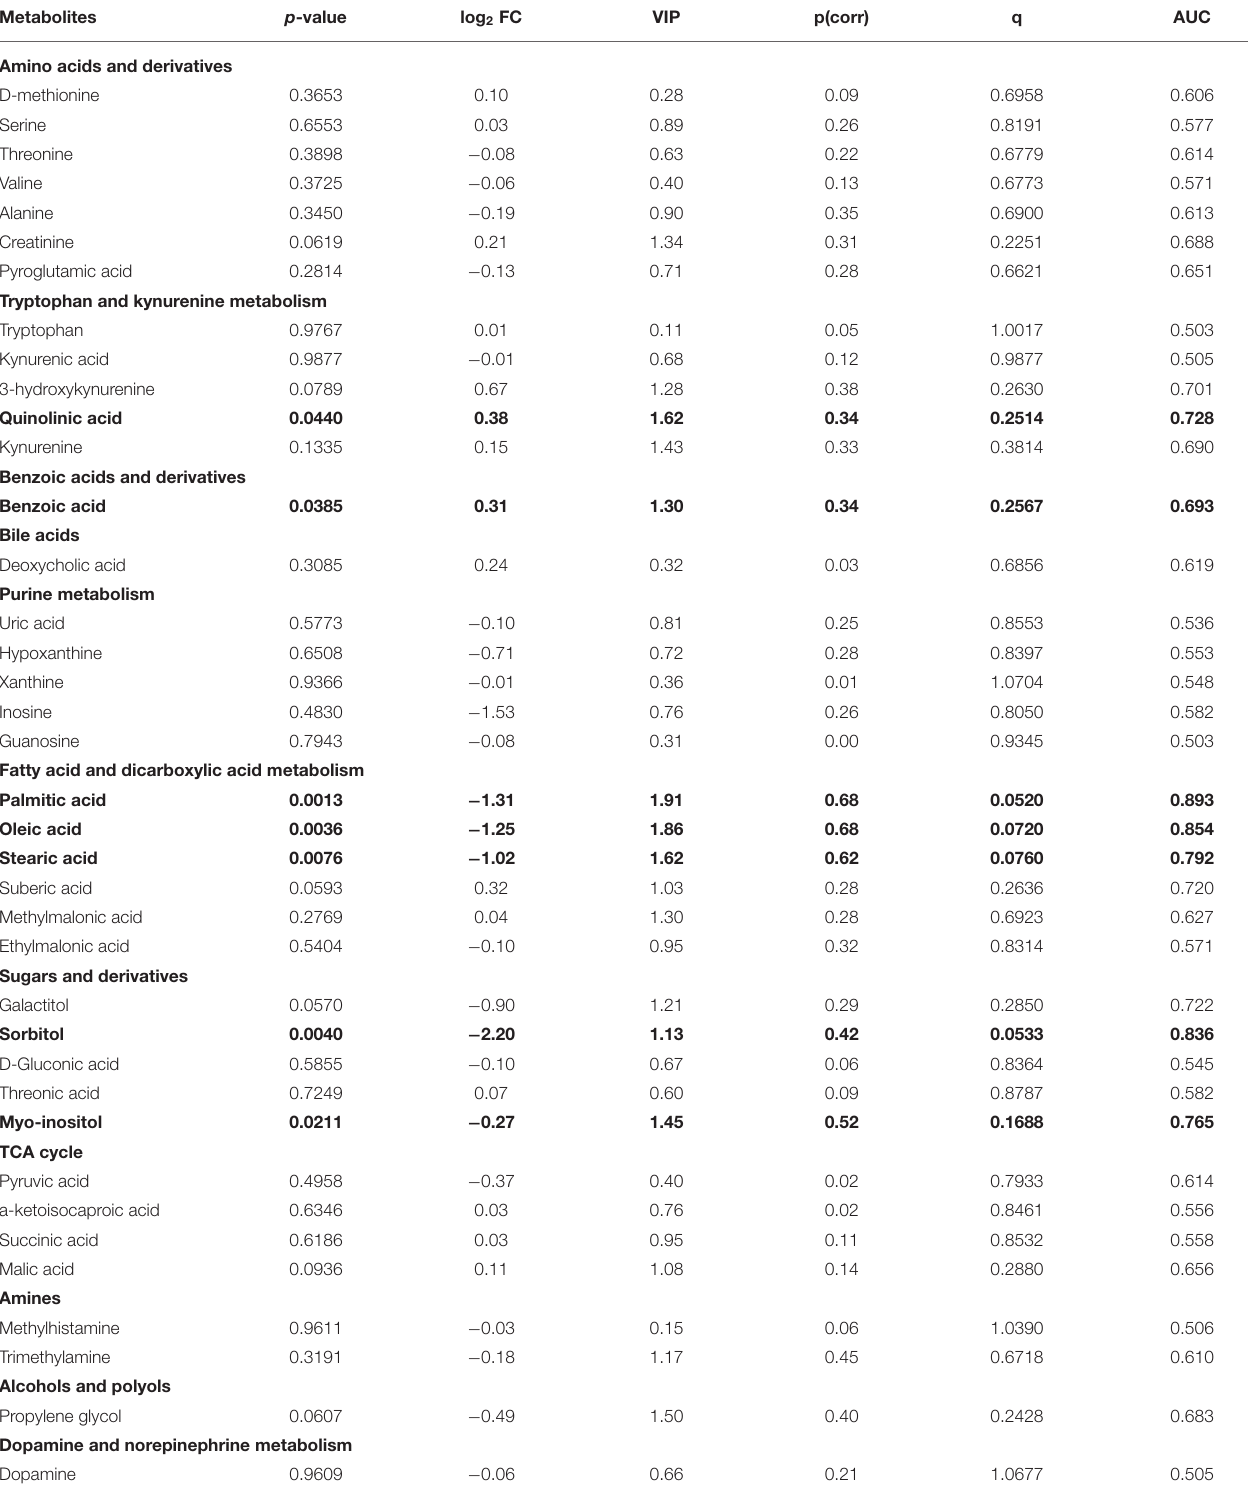
TABLE 4 | List of analyzed metabolites together with their p -values, log 2 FC values, variable importance in projection (VIP), p(corr) scores, corrected p -values, and the area under the curve (AUC) scores.